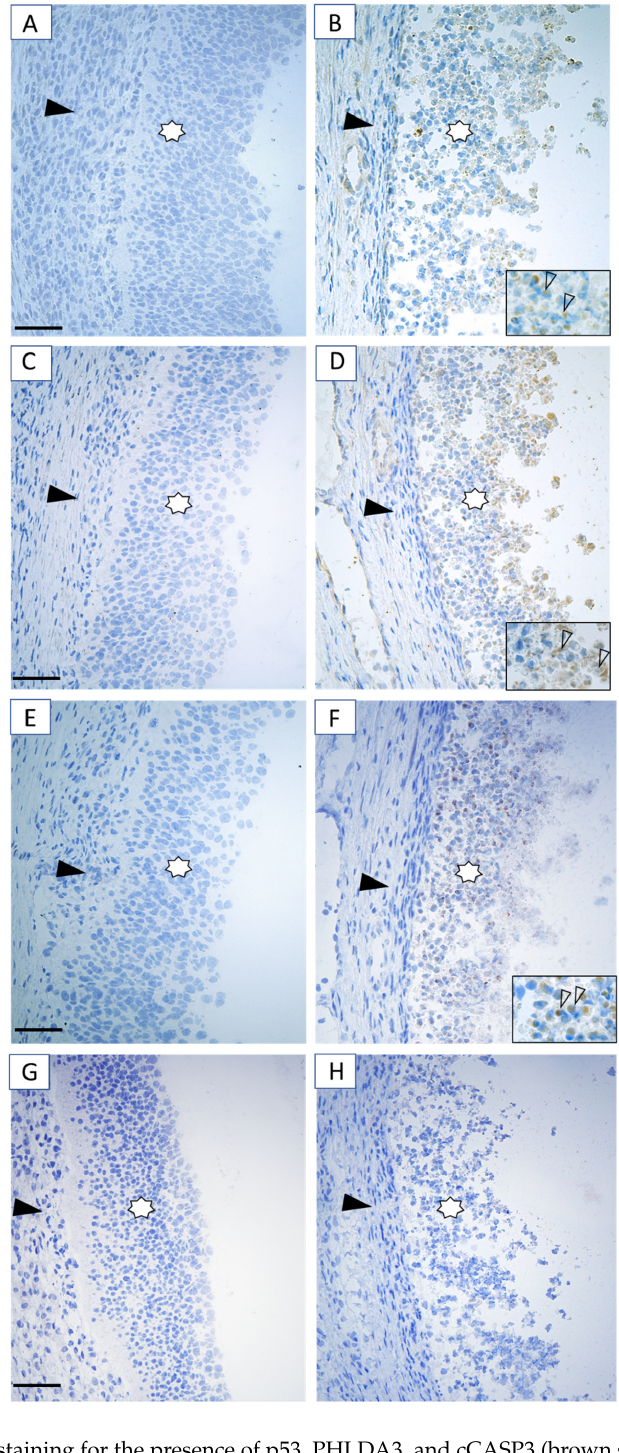
Figure 7. Immunostaining for the presence of p53, PHLDA3, and cCASP3 (brown staining) as markers of the p53 signaling pathway and apoptosis in the HA ( A , C , E ) and AA ( B , D , F ) follicles ( n = 6, ovaries). ( A , B ) Representative immunostaining of p53, ( C , D ) PHLDA3, ( E , F ) cCASP3, and ( G , H ) negative controls. Immunostaining of p53, PHLDA3, and cCASP3 was faint to absent in granulosa cells of HA follicle, but moderate to strong in granulosa cells of AA follicles. Staining was faint to absent in theca cells. Insets show a detail of the granulosa layer. Granulosa cells are indicated by asterisks, theca cells by an arrowhead. Scale bars represent 50 µ m. HA, healthy antral follicles; AA, atretic antral follicles. cCASP3, cleaved caspase